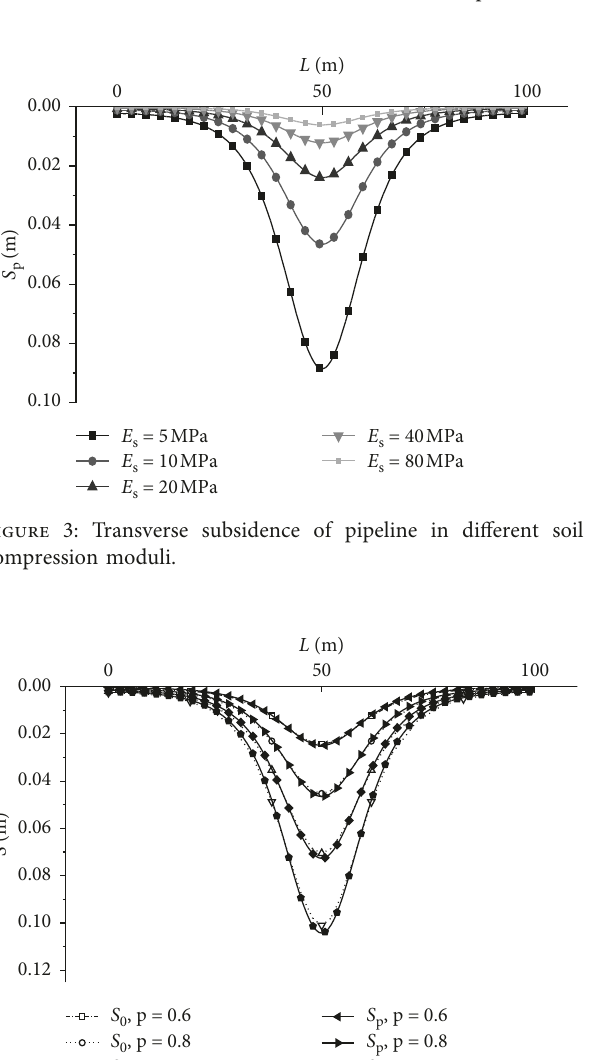
Figure 2: Vertical displacement of the pipeline at the face of tunneling.